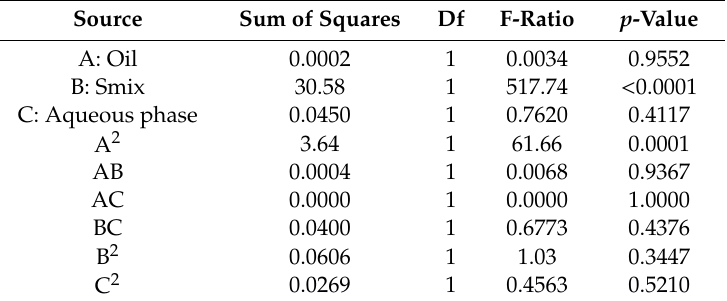
Figure 5. Effect of independent variables on PDI: ( A ) perturbation graph, ( B ) contour plot, ( C ) 3D surface plot and ( D ) predicted vs. actual plot. Table 4. Analysis of variance data for surface